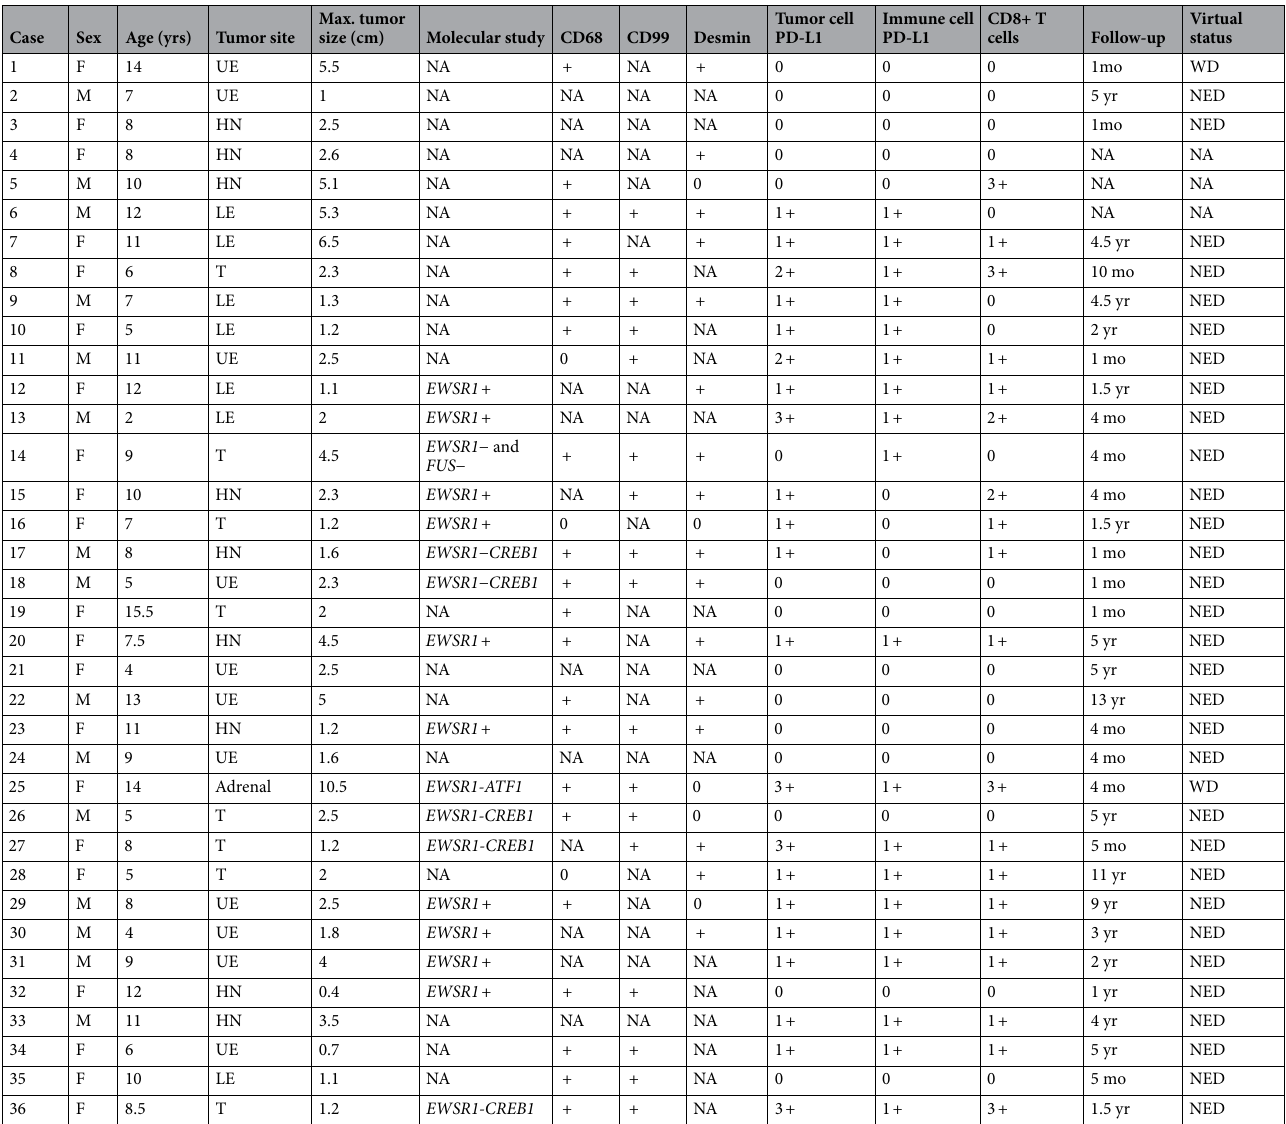
Table 1. The clinicopathologic features of 36 cases. F, female; M, male; UE, upper extremity; HN, head and neck; LE, lower extremity; T, trunk; NA, not available ; + , positive; 1 + , positive staining in 1% to 10% cells for PD-L1, 10–49 positive cells per 200 × field for CD8; 2 + , positive staining in 11% to 30% cells for PD-L1, 50–100 positive cells per 200 × field for CD8; 3 + , positive staining in > 30% cells for PD-L1, > 100 positive cells per 200 × field for CD8; mo, month; yr, year; WD, with disease; NED, no evidence of